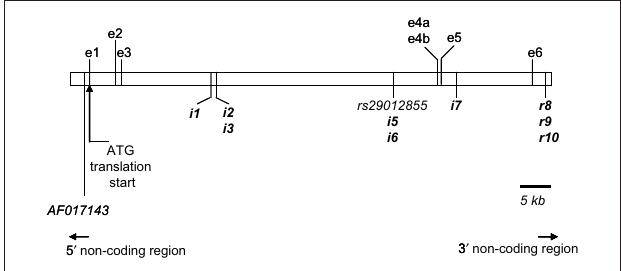
FiGuRe 1 | Annotation of IGF-1 (white box) on BTA5 as per build 4.0 of the Bos taurus genome sequence. The physical location of each of the 11 segregating SNPs used in this study is indicated in relation to contig BTA5. The putative nine novel SNPs are highlighted in bold (with the IGF1 prefix omitted for clarity). The two previously reported SNPs are listed as per their dbSNP accession number (http://www.ncbi.nlm.nih.gov/projects/SNP) or